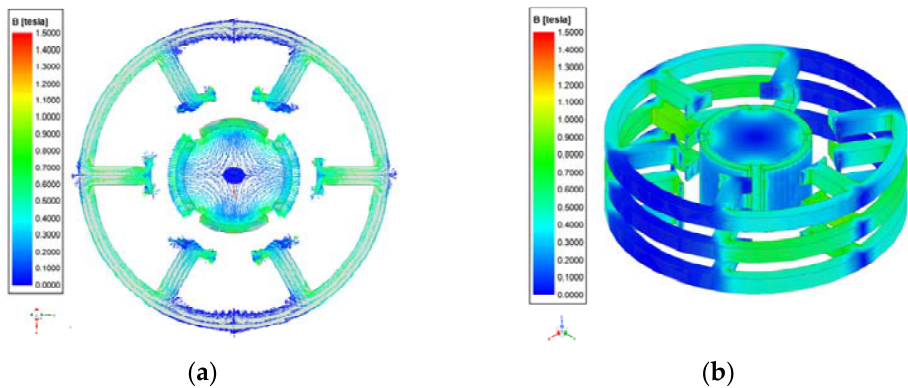
Figure 6. Magnetic field distributions of the motor under no-load conditions: ( a ) magnetic field vectors from the top view of the motor; ( b ) magnetic field distribution from the isometric view of the motor.